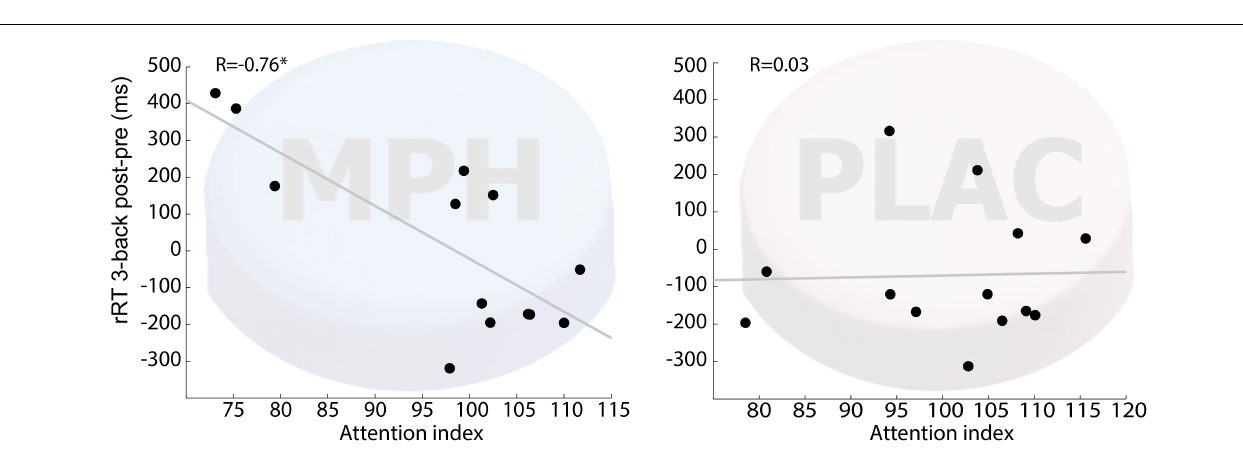
FIGURE 3 | Correlation between attention index during the induction phase and 3-back RT difference (post vs. pre drug-task coupling). Performance on cognitive induction task coupled with MPH, but not with placebo, showed a significant correlation with 3-back RT change during scanning ( R = –0.76; p < 0.01). MPH-Cogni. * p < 0.05 and ** p <